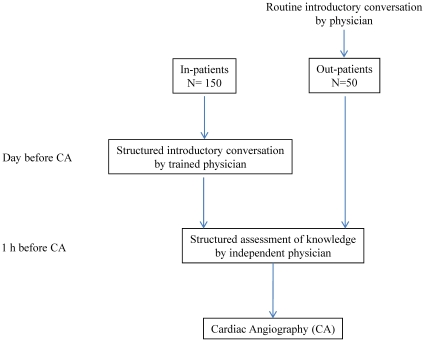
Study flow-chart.